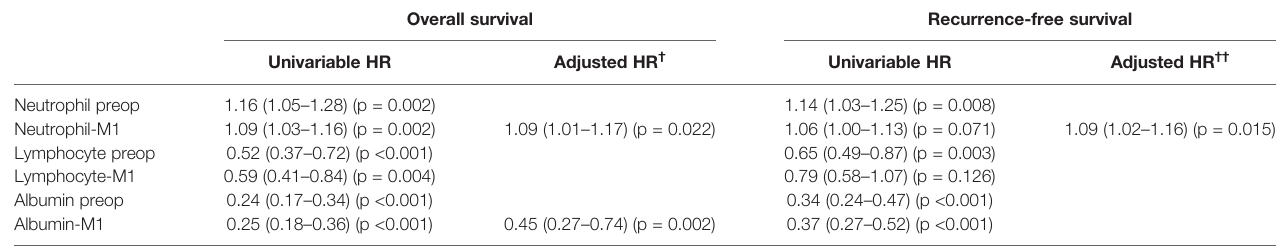
TABLE 2 | Univariable and multivariable analyses for overall and recurrence-free survival. Overall survival Recurrence-free survival Univariable